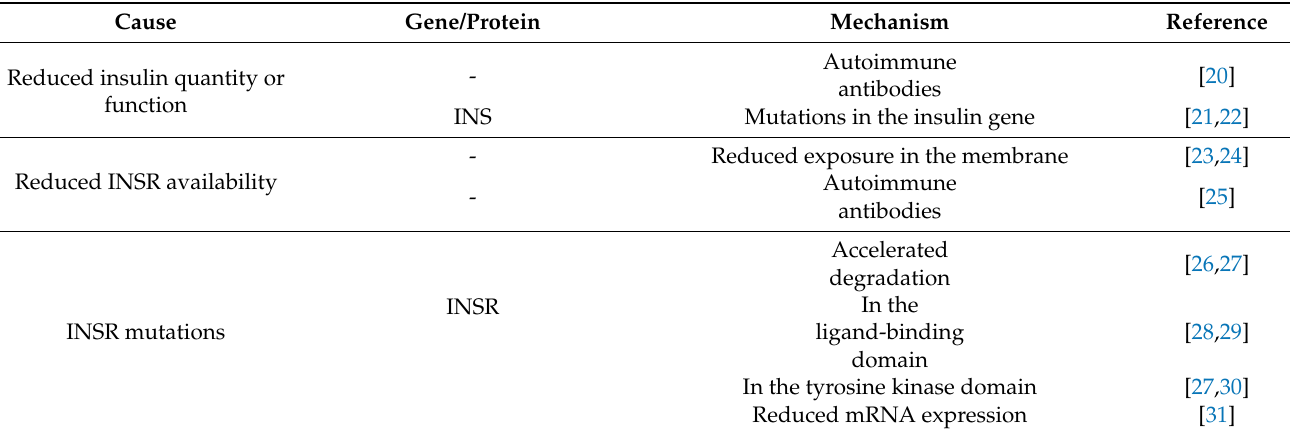
Table 1. Etiology of insulin resistance